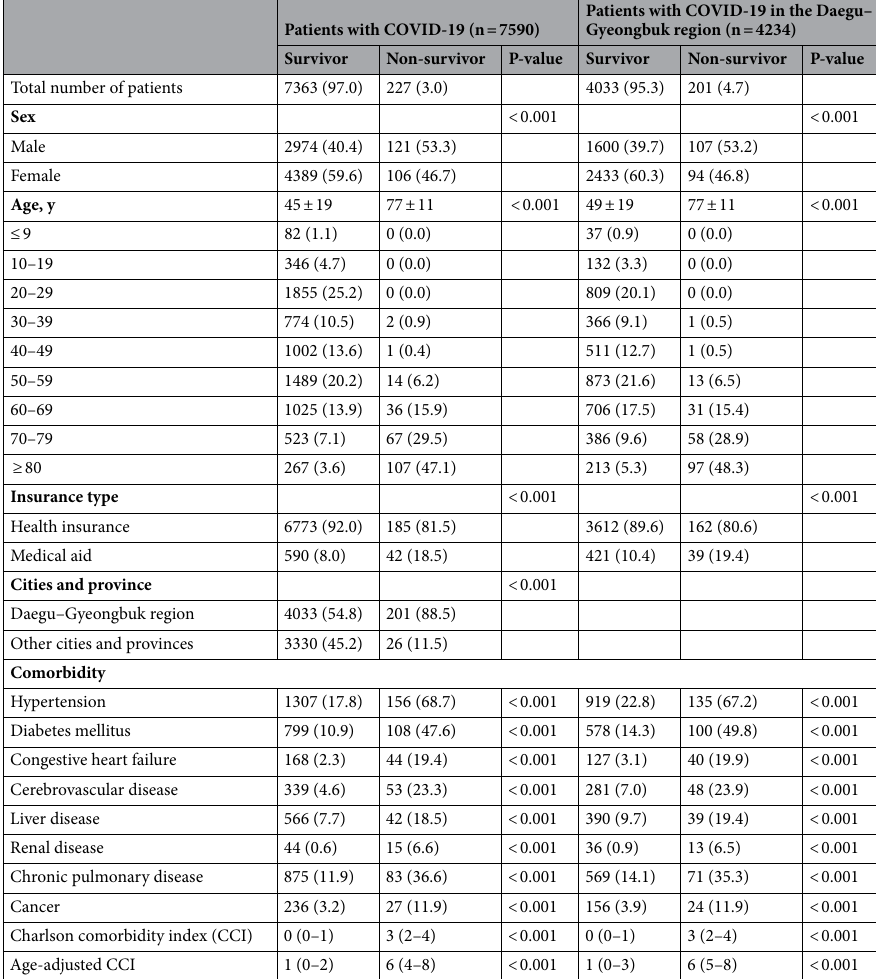
Table 1. Baseline characteristics and comorbidity of patients with coronavirus disease (COVID-19). Data are presented as number